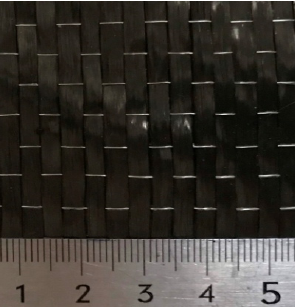
Table 2. Mechanical properties of adhesive, CFRP sheets, and steel reinforcement.